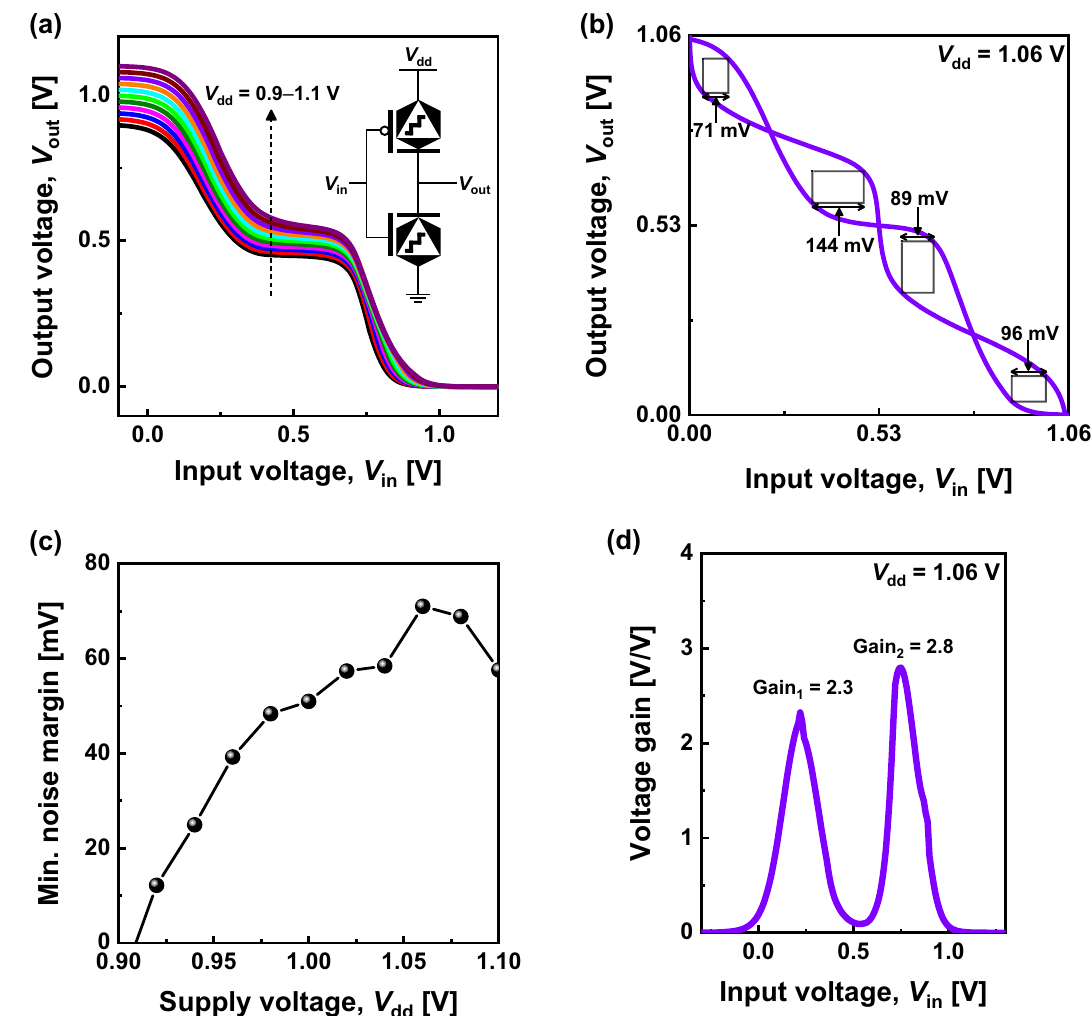
Figure 5. ( a ) Voltage transfer characteristics of STIs for V dd = 1 ± 0.1 V (inset: schematic of the transfer level of a complimentary STI circuit). ( b ) Butterfly curve with noise margins of STI for V dd = 1.06 V and ( c ) minimum noise margins extracted as a function of V dd . ( d ) Voltage gains of two-state transitions for V dd = 1.06